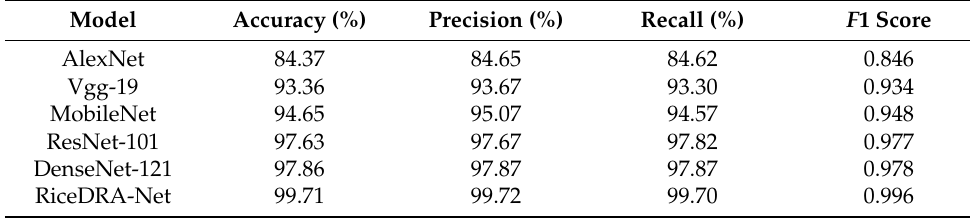
Table 6. Comparison of various classical models under